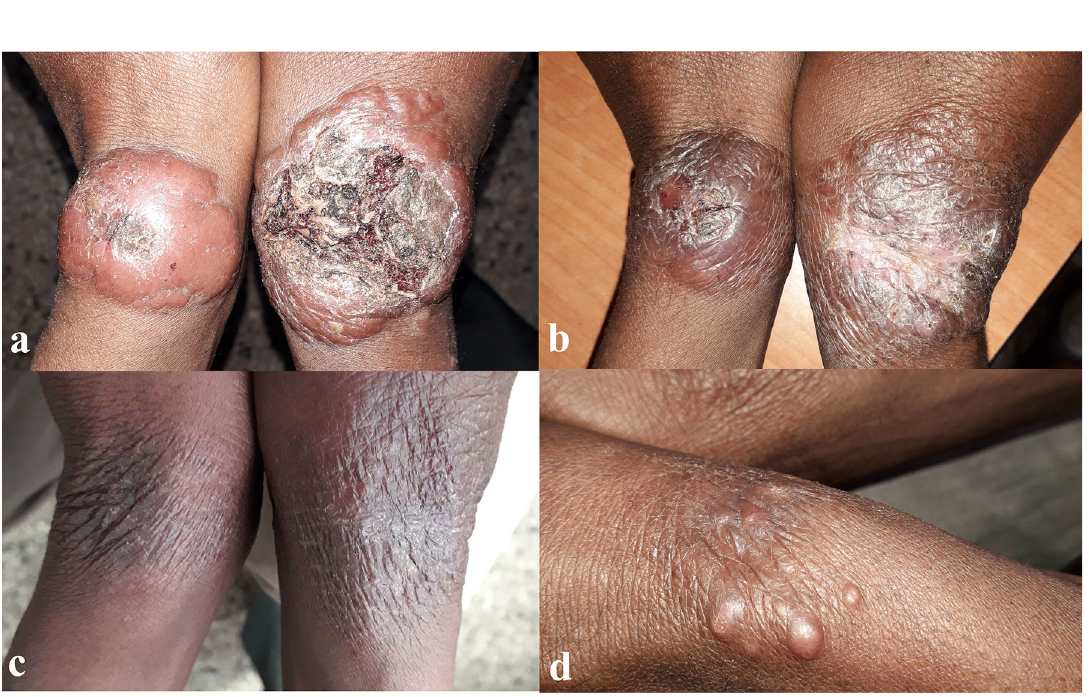
Fig 3. Patient with two large symmetric lesions classified as LCL on both wrists of nine months duration. Lesions show nodular erythema with central ulceration and superinfection at day 0 (A). The lesion showed progressive improvement at day 28 (B) and day 90 (C) with almost complete flattening and reepithelization. At day 180, new nodules appeared on the site of the previous lesion, indicating relapse